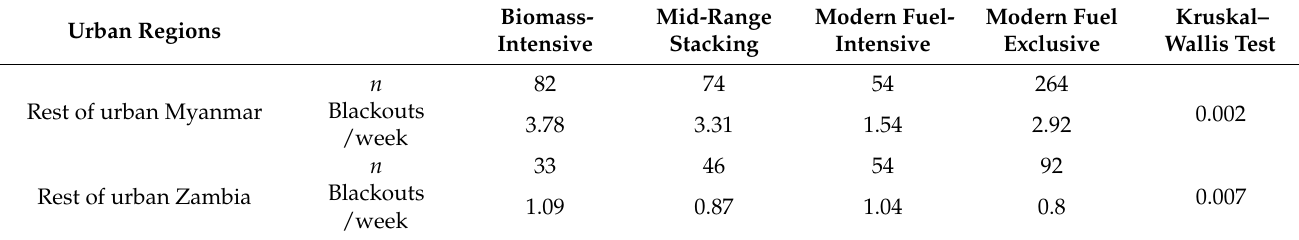
Table 13. Average number of blackouts experienced by households in a typical week ( n = number of respondents). Urban